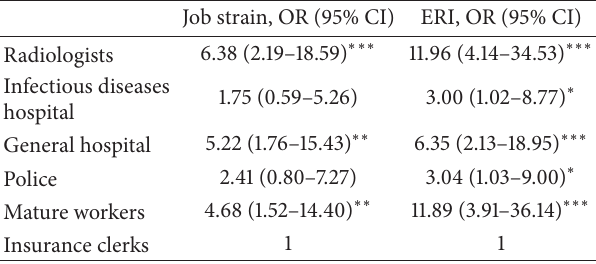
Table 3: Odds ratios (ORs) and 95% confidence intervals (CIs) of job strain and effort/reward imbalance by occupational group (odds for insurance clerks = 1). Adjusted for age and